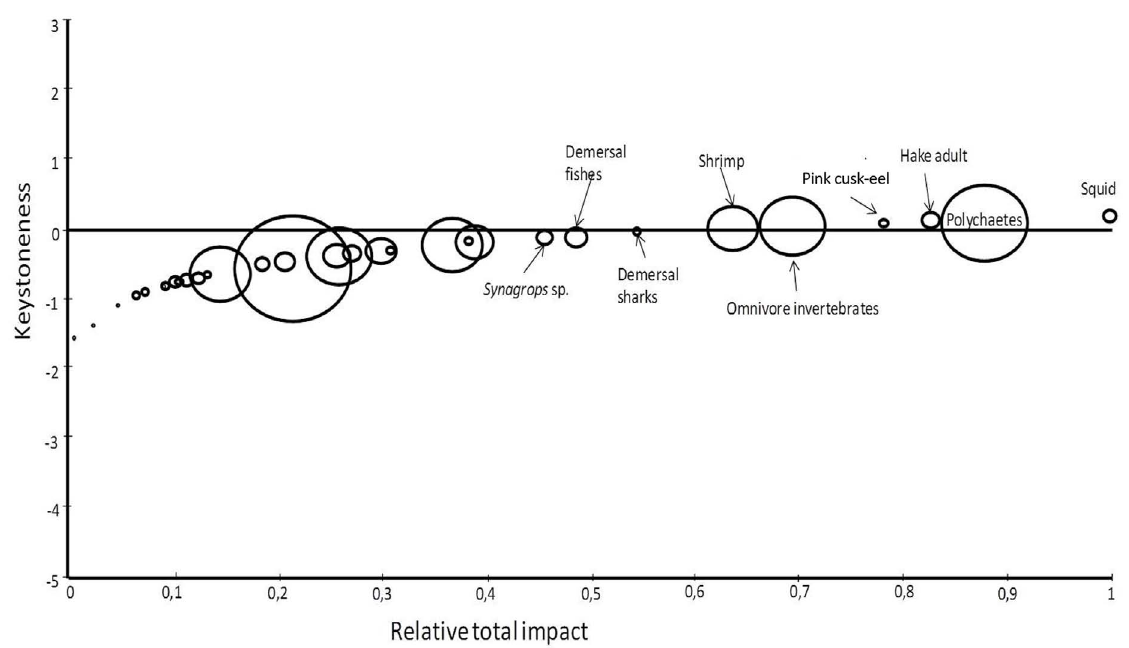
Fig. 3. – Graph of keystone species indices. Circles represent the functional groups; the sizes of each circle are proportional to the relative biomass of each functional